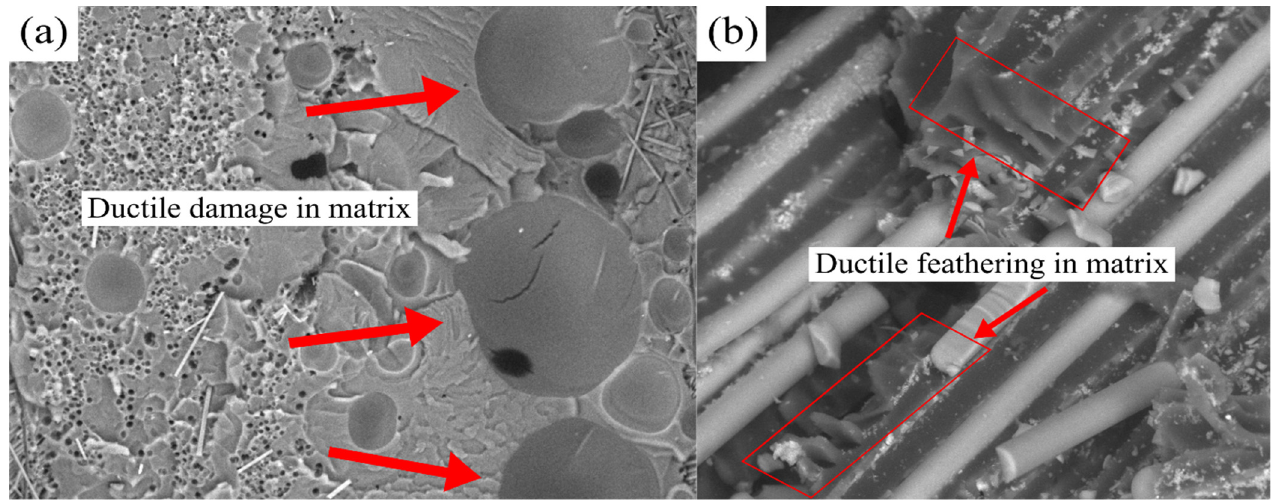
Figure 2. The evidence for ductile damages in matrix: ( a ) rCF/EP; ( b ) rGF/EP.